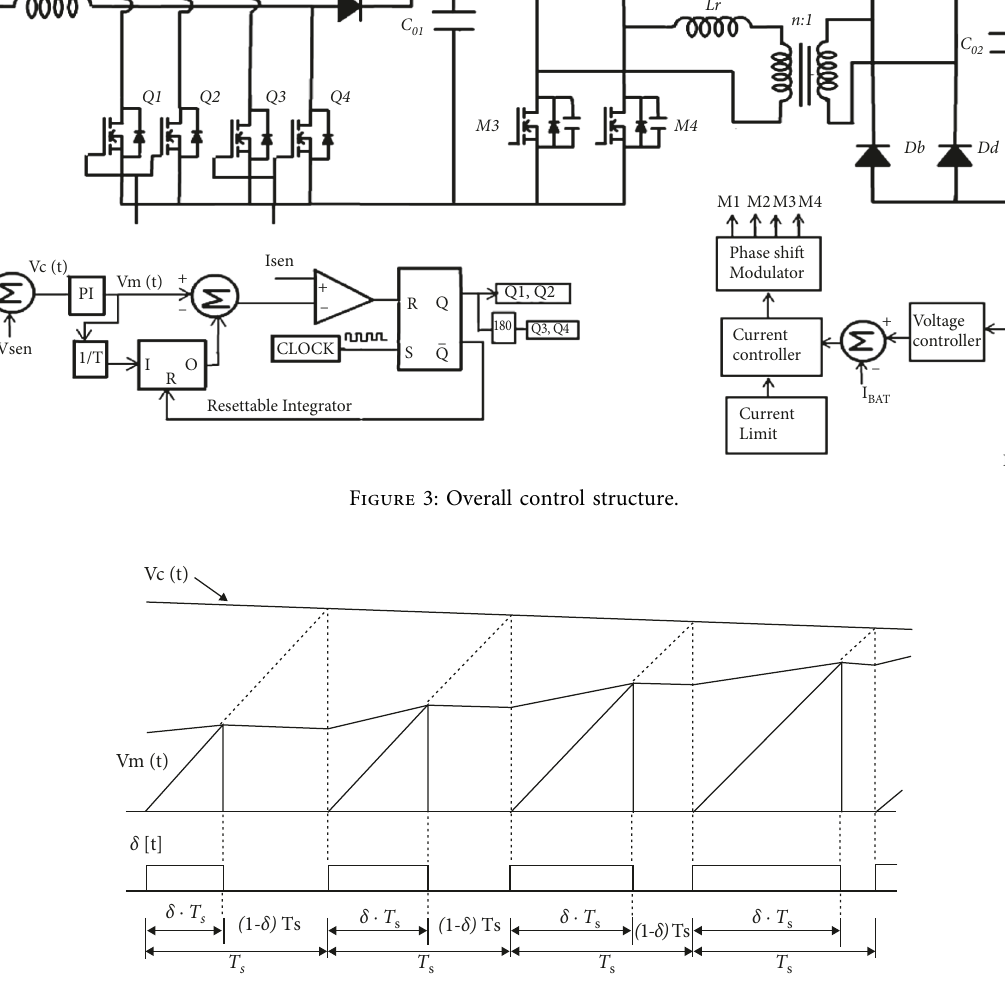
Figure 4: Theoretical waveform of RI